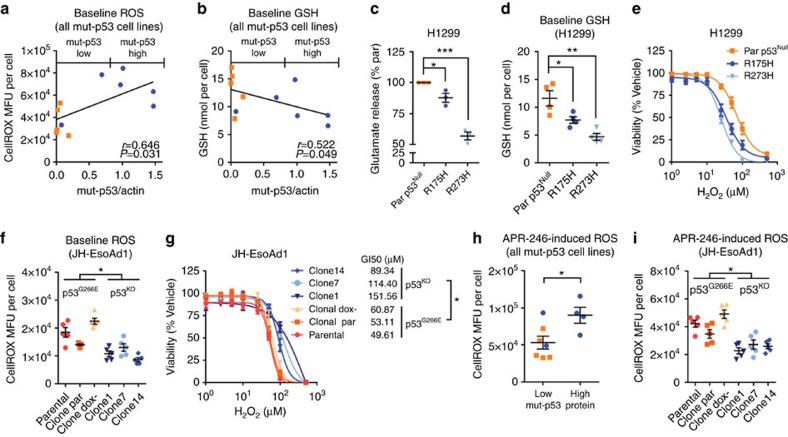
Mut-p53 accumulation sensitizes cancer cells to oxidative stress.(a,b) Correlation of mut-p53 protein (normalized to β-actin) with ROS (a) and glutathione (GSH) (b) levels under basal growth conditions for all mut-p53 cancer cell lines used in this study. For further analysis cell lines were dichotomized into mut-p53 high and low expressers based on western blot in Fig. 4a. (c) System xc− activity as assayed by glutamate release from p53Null, p53R273H and p53R175H H1299 cells. Cells were stimulated with 600 μM L-cystine for 3 h prior to glutamate assay. (d) GSH levels at rest in p53Null, p53R273H and p53R175H H1299 cells. (e) Cell viability at 96 h post H2O2 treatment in p53Null, p53R273H and p53R175H H1299 cells. (f) ROS levels at rest in p53G266E and mut-p53KO JH-EsoAd1 cells. (g) Cell viability at 96 h post H2O2 treatment in p53G266E and mut-p53KO JH-EsoAd1 cells. (h) ROS levels 6 h post 50 μM APR-246 treatment in all mut-p53 cancer cell lines grouped by endogenous mut-p53 protein levels as determined in a,b. (i) ROS levels 6 h post 50 μM APR-246 treatment in p53G266E and mut-p53KO JH-EsoAd1 cells. Pearson's correlation (a,b), one-way ANOVA with Dunnett's multiple comparison post-test (c,d), unpaired t-test (f–i). Error bars=s.e.m., n=3 for all except (d) n=4 and (f,i) n=5, *P<0.05, **P<0.01, ***P<0.001. See also Supplementary Fig. 5.